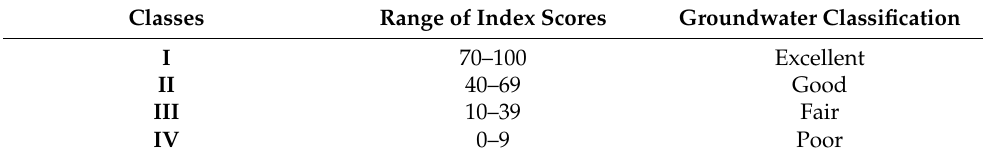
Table 13. Groundwater classification for the index value.